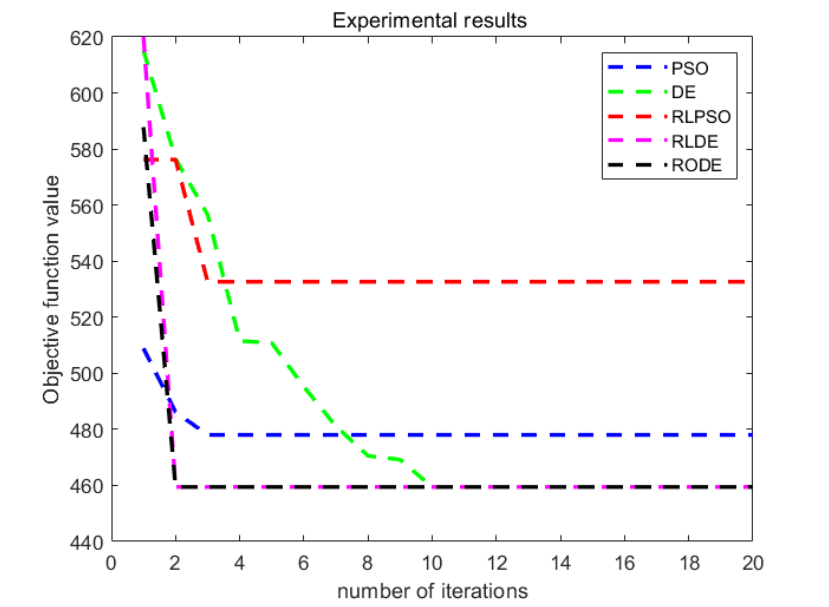
Figure 8. Experimental comparison with an initial population of 200.